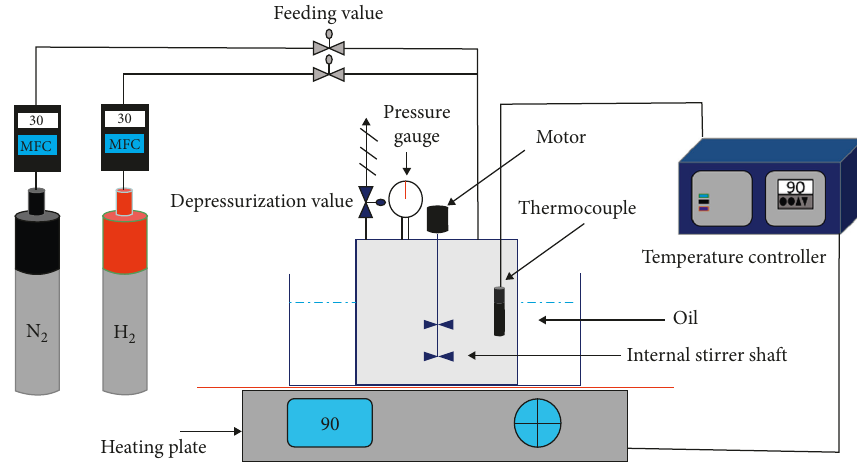
Figure 2: Scheme of the batch